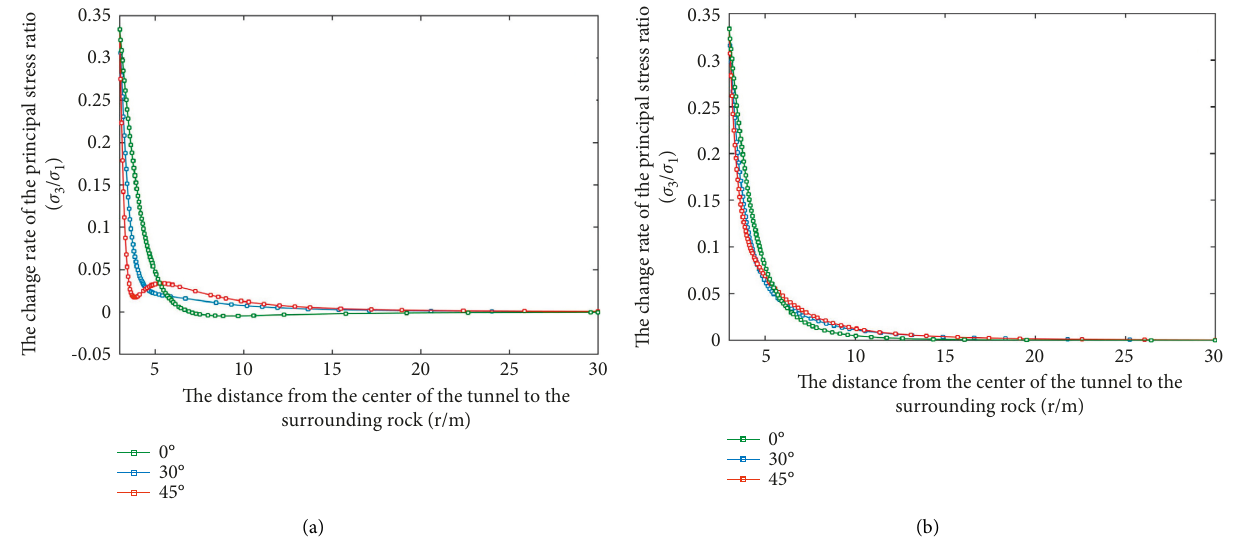
Figure 8: Change rates of principal stress ratio under different lateral pressure coefficients λ . (a) λ � 0.3. (b) λ � 0.5.